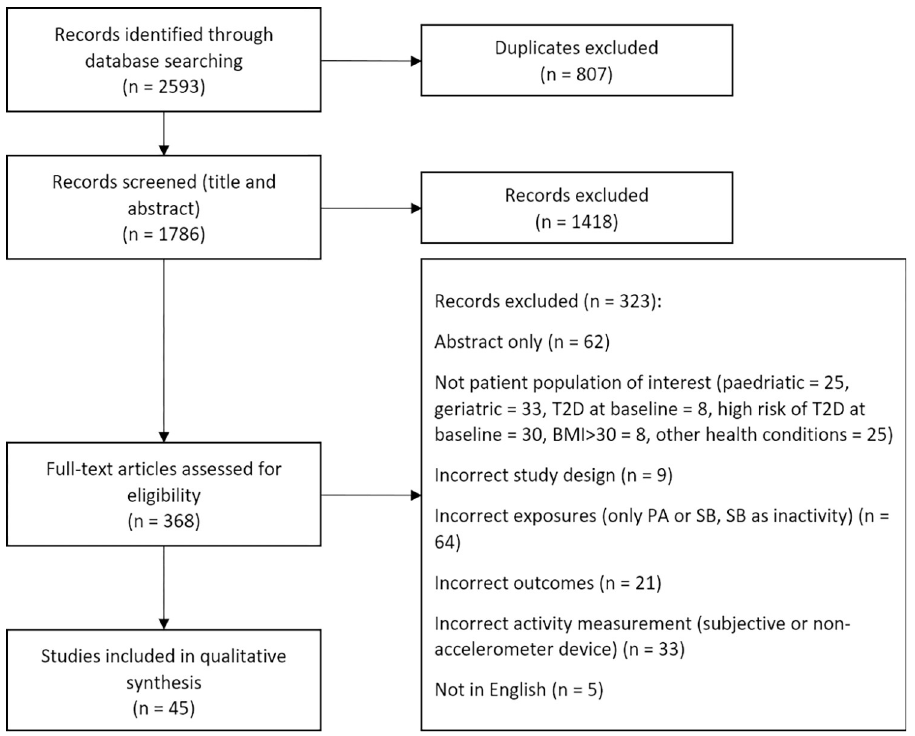
Fig 1. PRISMA flow diagram of study selection